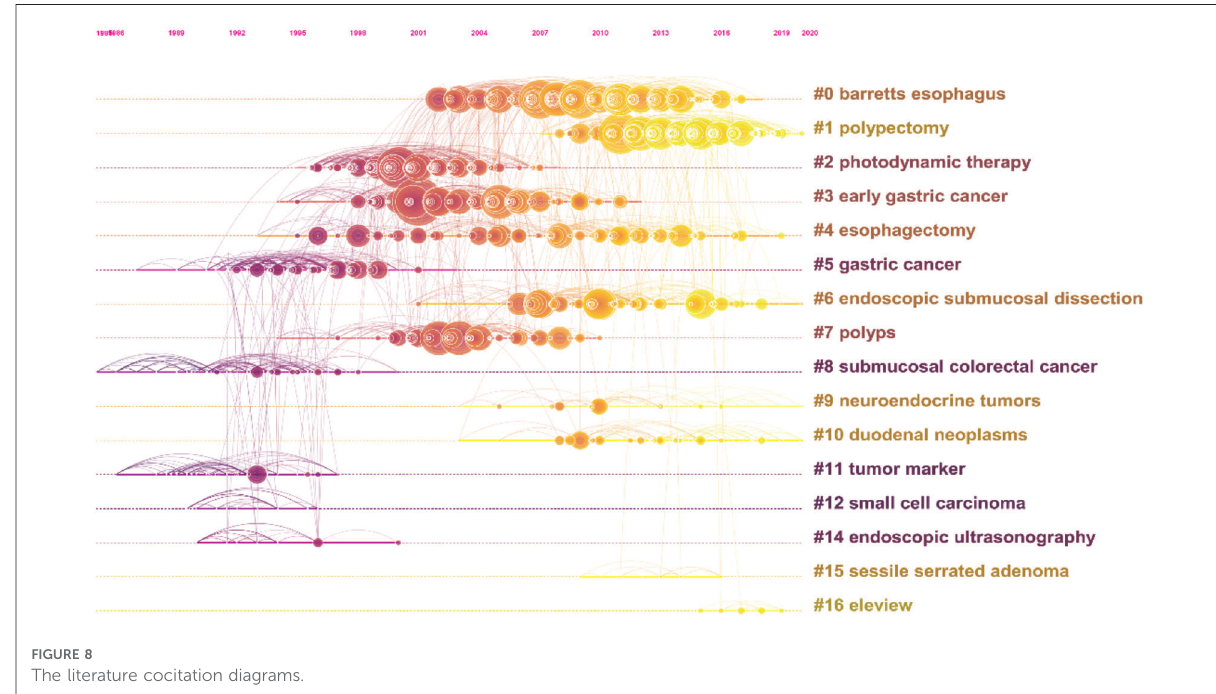
FIGURE 8 The literature cocitation diagrams.